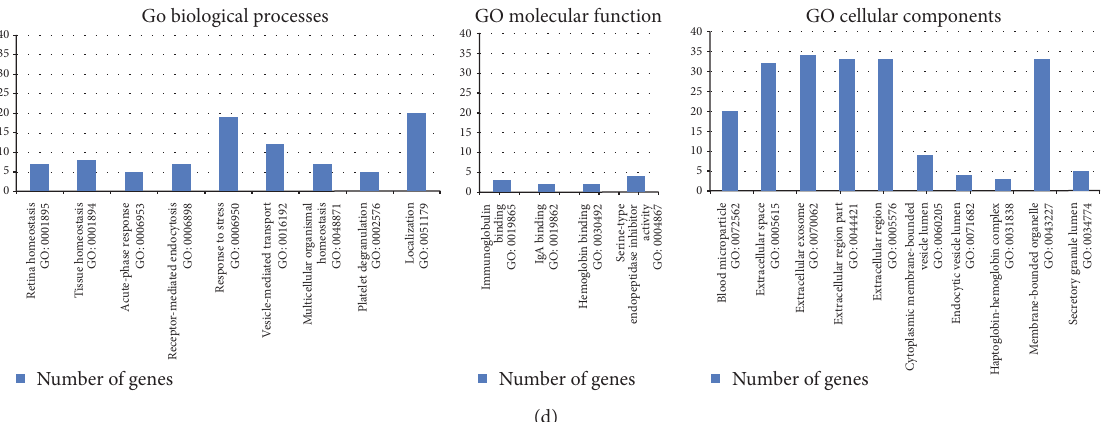
Figure 4: Proteomic analysis of urinary extracellular vesicles: mass spectrometry results from representative samples. (a) Venn diagram shows that in EVs from controlled diabetic patient with microalbuminuria there is a large number of unique proteins ( 𝑛 = 49 ), in a healthy control and in an uncontrolled diabetic patient with macroalbuminuria the number of unique proteins is very low ( 𝑛 = 4 ) [20]. (b) Protein- to-protein interaction analysis of common 45 proteins selected from Venn diagram shows the central role of albumin among urinary EV- related proteins; the list of submitted proteins is available in a supplementary data file (Supplementary Table 2 ) [22]. (c, d) Gene Ontology analysis showed that most of identified proteins are related to extracellular region or they are related to membrane organelles (exosomes); their localization corresponds with molecular function (receptors and transport proteins) [19]. A1BG: alpha-1-B glycoprotein; A2M: